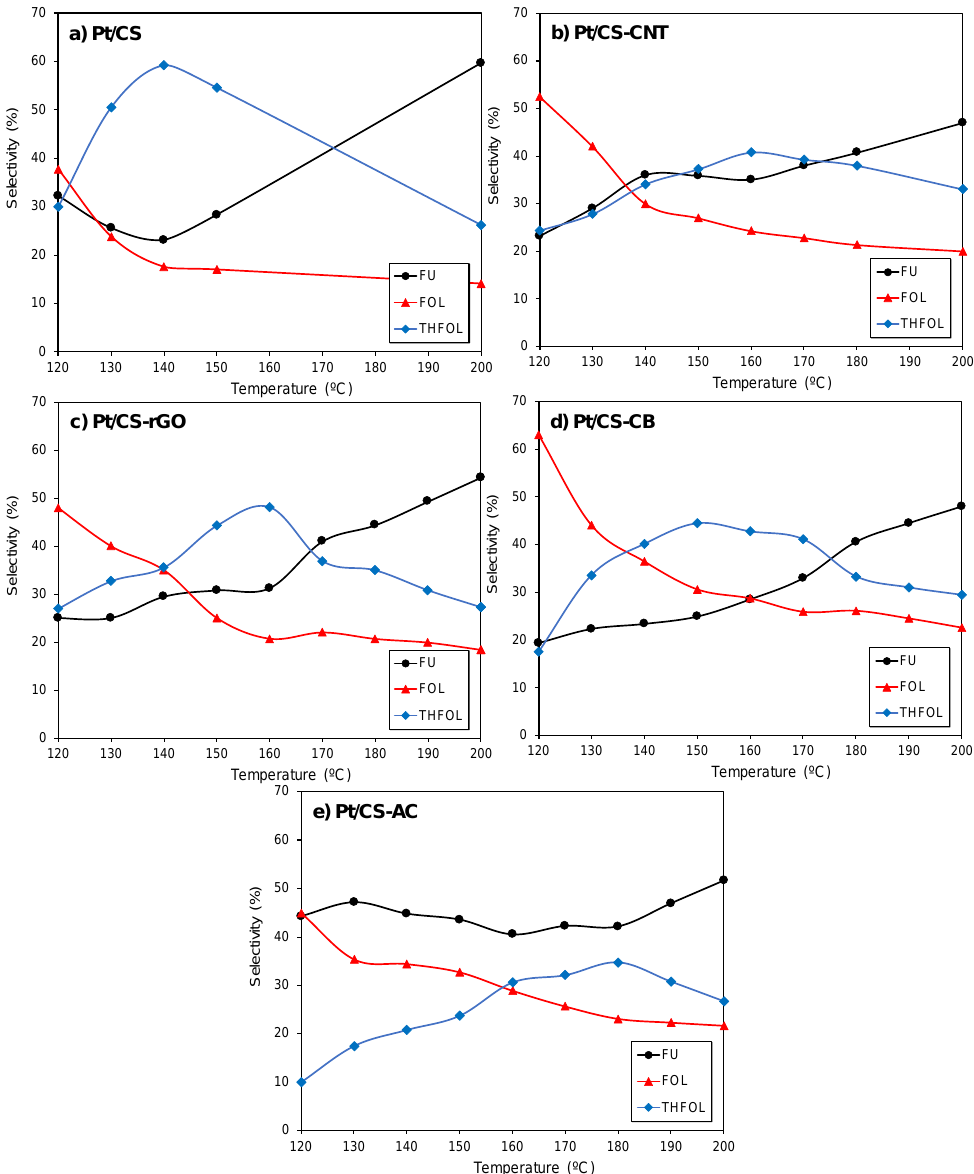
Figure 8. Products distribution obtained as a function of reaction temperature over all Pt/carbon catalysts: ( a ) Pt/CS, ( b ) Pt/CS-CNT, ( c ) Pt/CS-rGO, ( d ) Pt/CS-CB and ( e ) Pt/CS-AC.